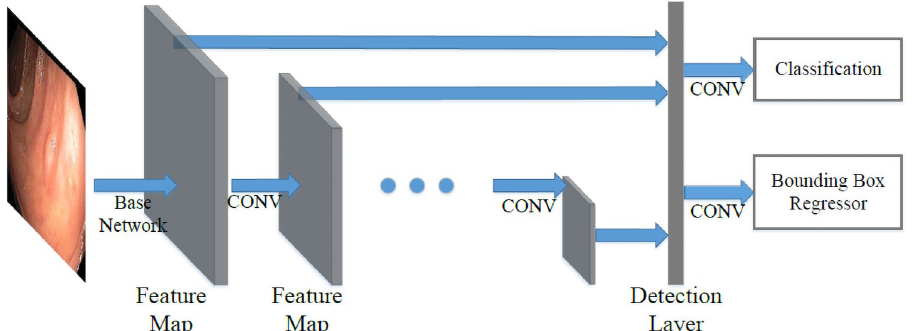
Fig 2. SSD structure. Base network is truncated from a standard network. The detection layer computes confident scores for each class and offsets to default boxes.